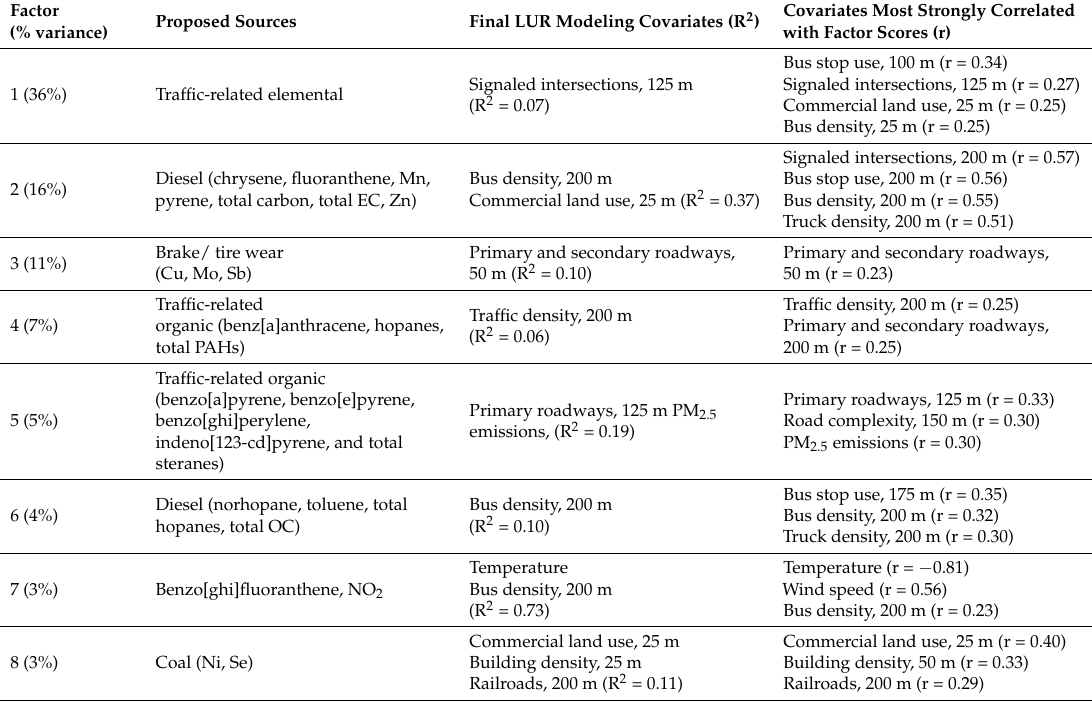
Table 4. Combined winter and summer factor score LUR (land use regression) results ( n =